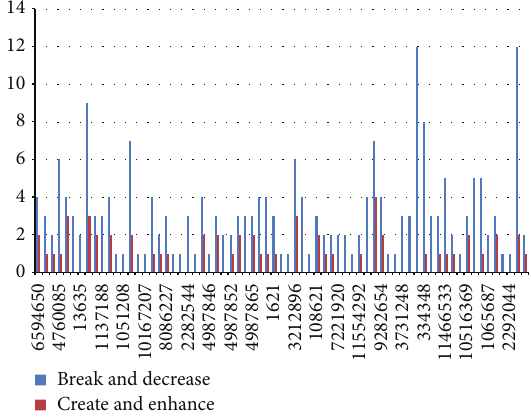
Figure 3: This chart like its previous counterpart shows overexpres- sion. It does by higher levels of breakage and decrease (blue) of C 󳨐⇒ T